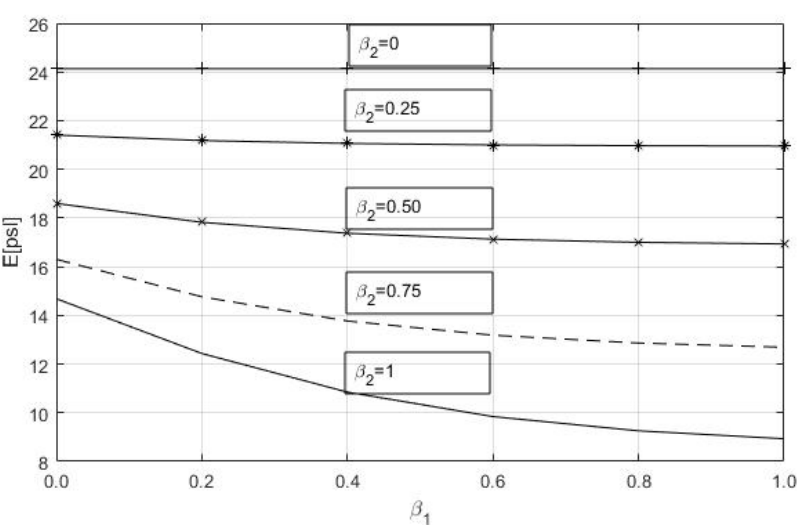
Figure 3: Impact of E [ psl ] on β